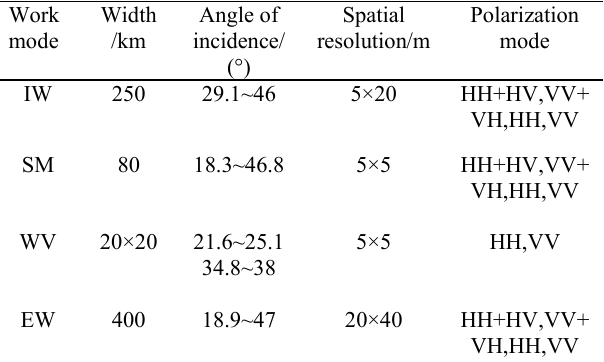
Table 1. Main parameters of Sentinel-1